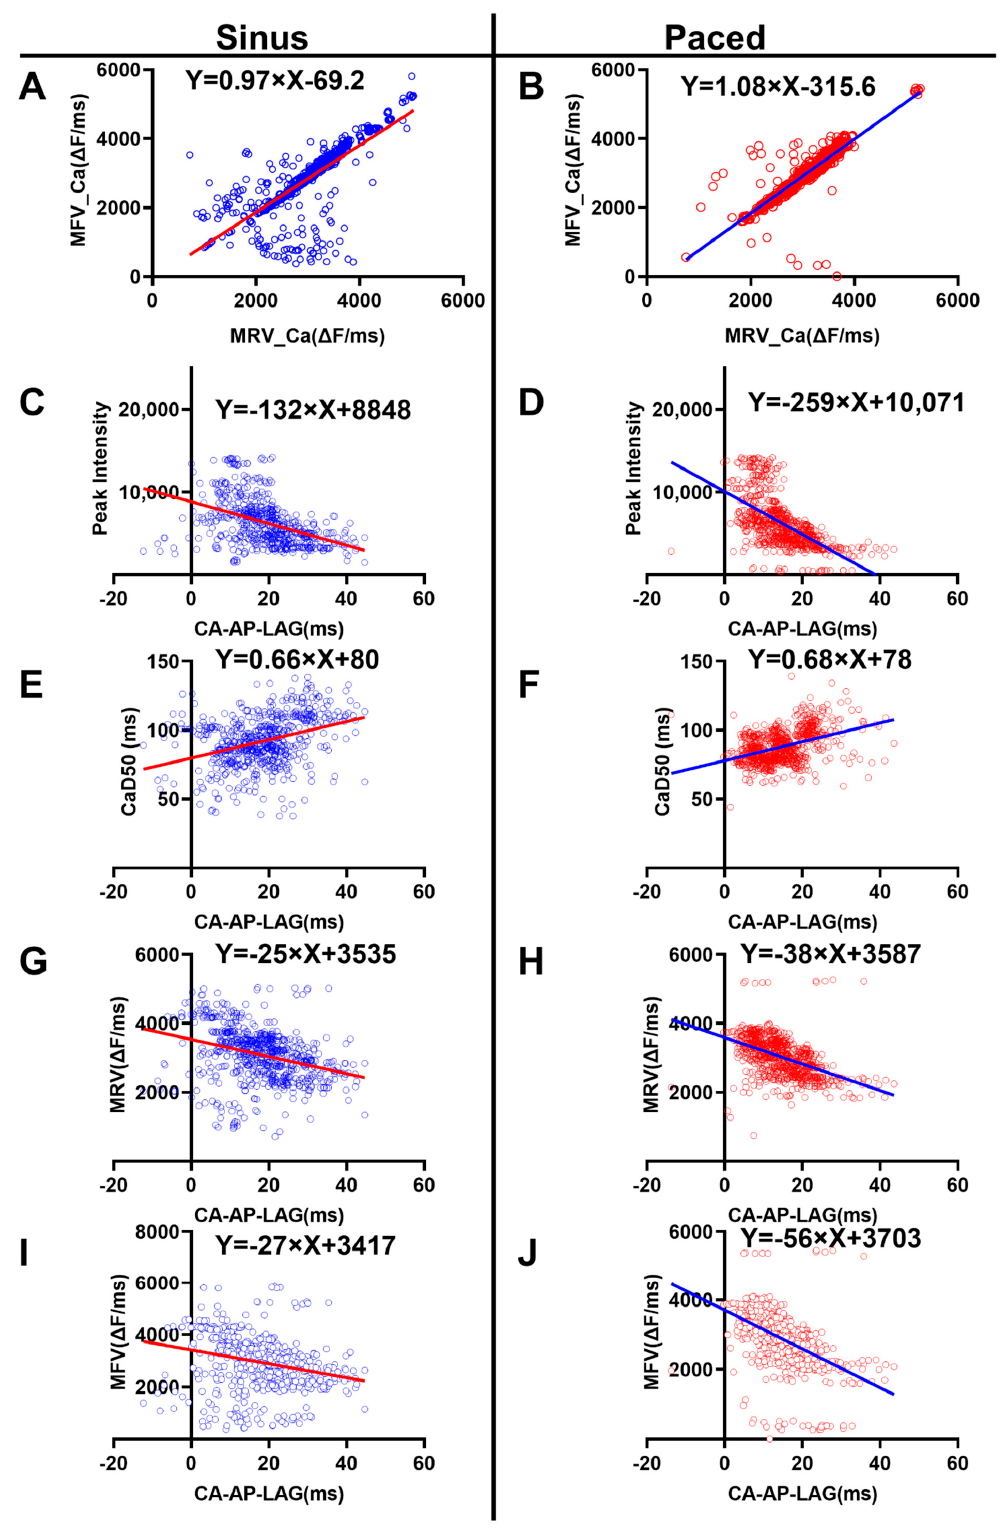
Figure 4. ( A , B ) The correlation of MRV_Ca and MFV_Ca in sinus group ( A ) and paced group. ( C – J ) the correlation of Ca-AP-Lag with the peak of Ca 2+ signal (( C ): sinus, ( D ): paced), CaD50 (( E ): sinus, ( F ): paced), MRV (( G ): sinus, ( H ): paced) and MFV (( I ): sinus, ( J ): paced). All the correlations were performed with Pearson analysis and were significant ( p < 0.01); and the equation Y = A × X ± B was employed to describe the simple linear regression (insets in each